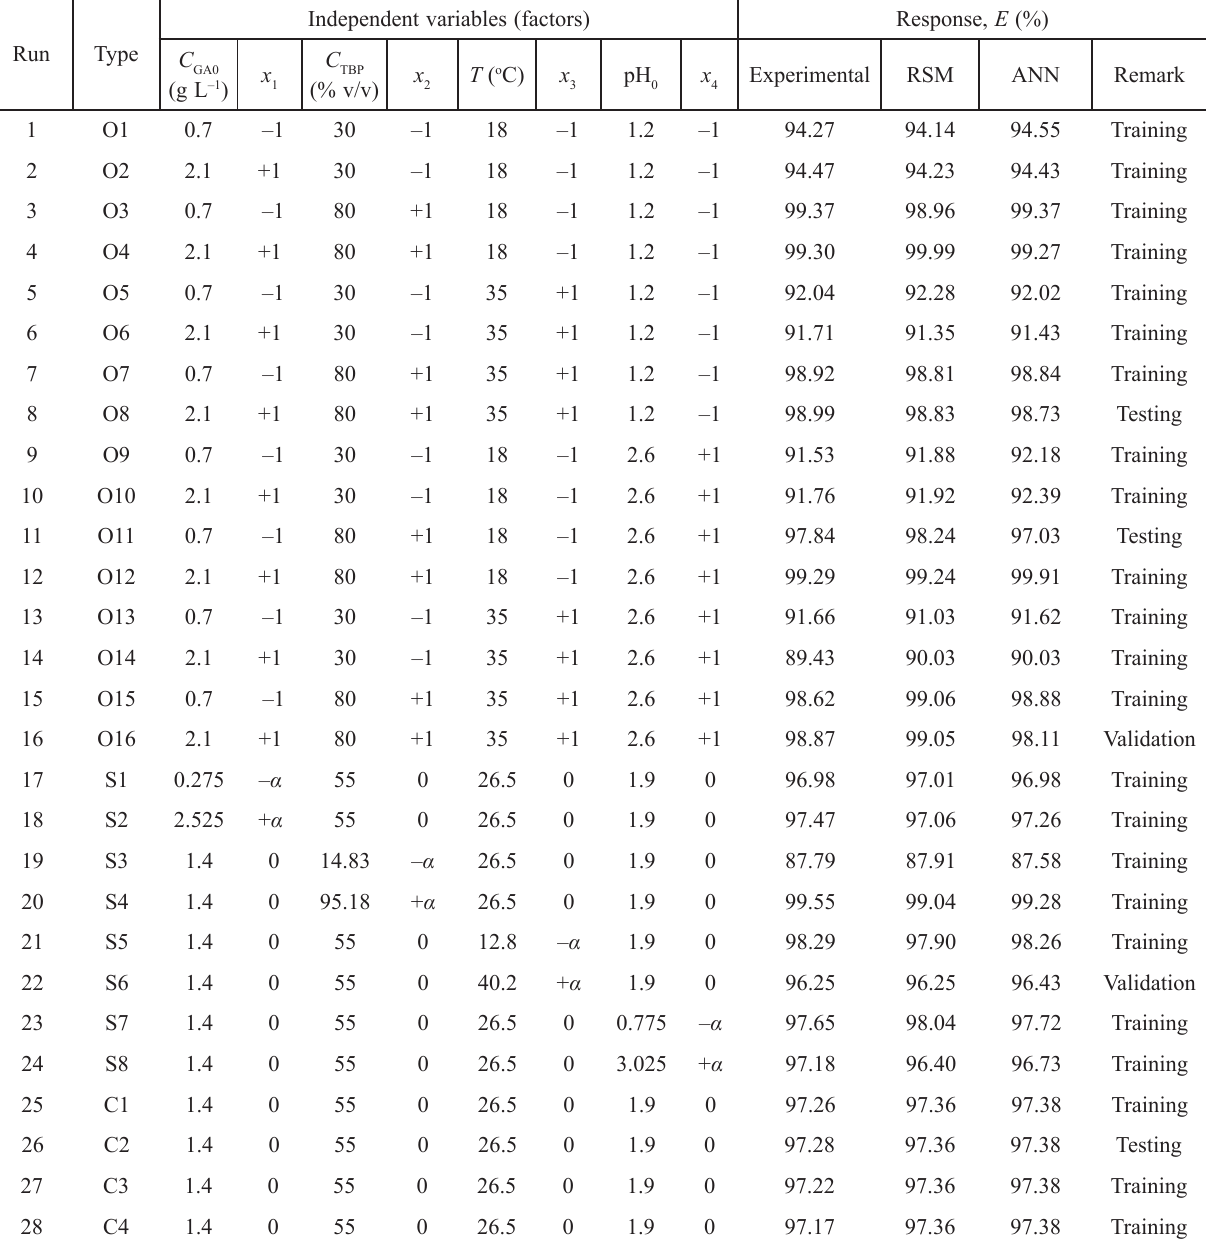
Table 1 – Rotatable orthogonal central composite design (RO-CCD) with experimental and predicted extraction efficiency of